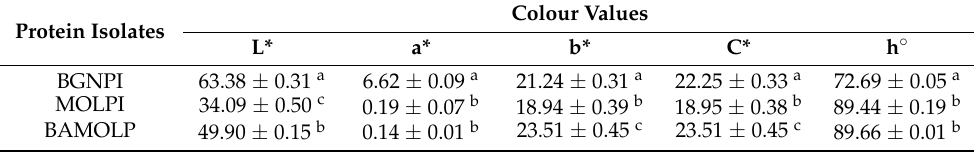
Table 1. Colour characteristic of BGNPI, MOLPI, and BAMOLP 1,2 . Protein